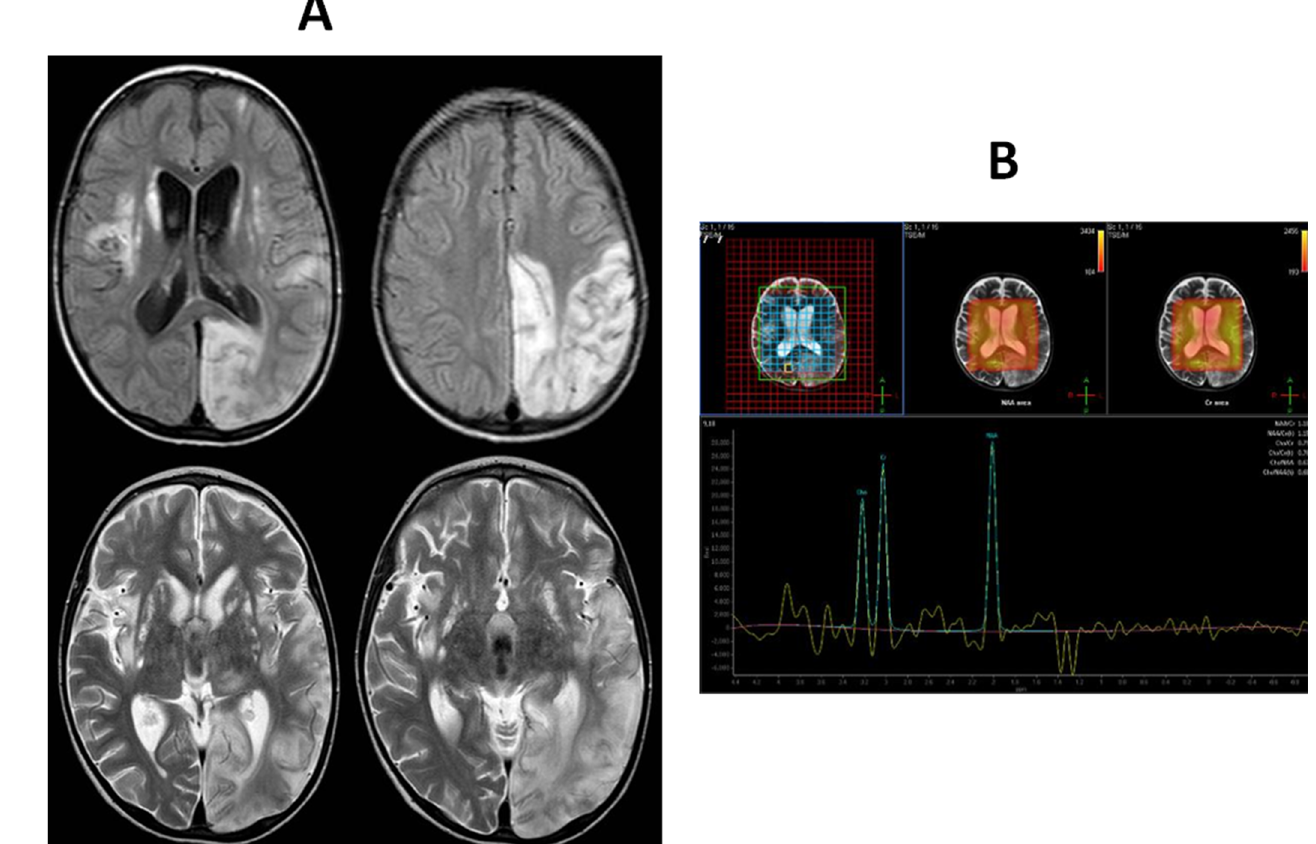
Figure 2. (A) Flair and T2-weighted MRI images showing cortical changes, especially in left hemisphere, incongruent to a vascular territory, with focal hyperintensities in basal ganglia; (B) Proton spectroscopy showing inverted peak of lactate at 1.3